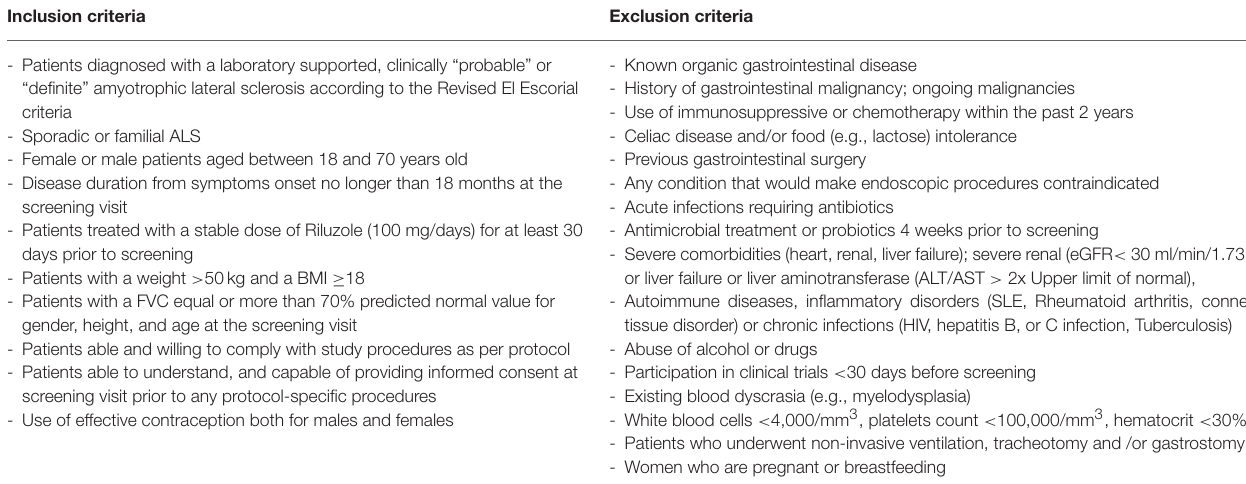
TABLE 1 | Inclusion and exclusion criteria for patients. Inclusion criteria Exclusion